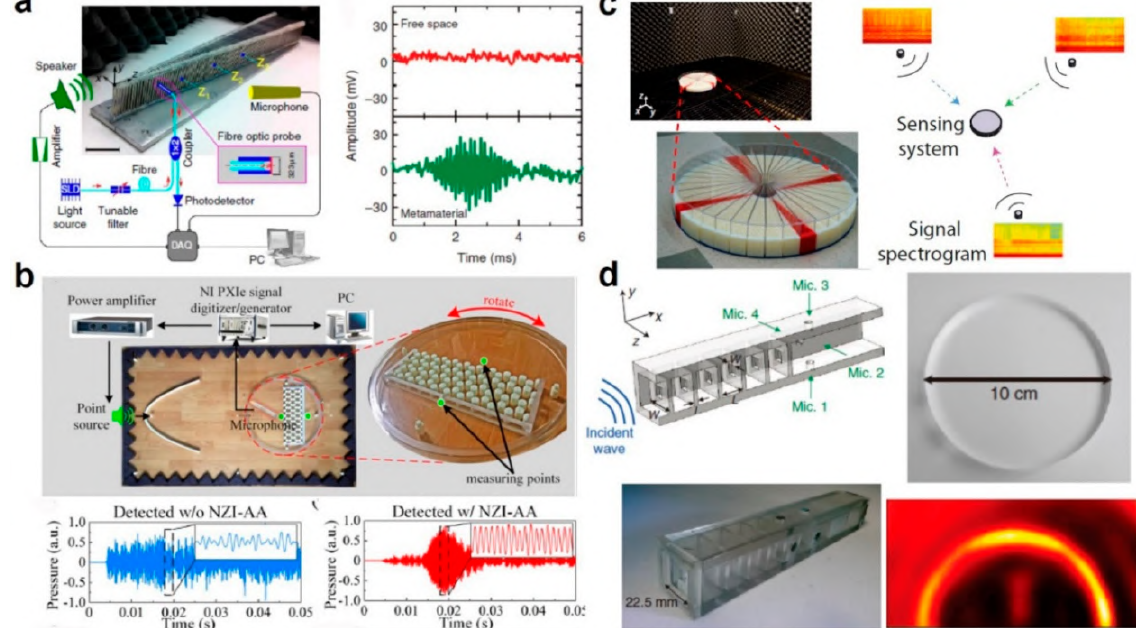
Figure 4. Acoustic metamaterials for sensing. ( a ) Schematic of the AMM hybrid sensing system, time-domain pulse signal in free space and in the metamaterial. Reproduced with permission from [96]. Copyright 2014, Nature. ( b ) Experimental setup for characterizing the NZI-AA sample on a rotating table, and time-domain pressure with and without the NZI-AA sample. Reproduced with permission from [11]. Copyright 2019, American Institute of Physics. ( c ) Fabricated metamaterial sensor and the schematic for the single-sensor listening device for sound detection from several sources. Reproduced with permission from [95]. Copyright 2015, PNA. ( d ) Schematic of the AMM with five symmetrical resonators, 3D printed prototype, optical image and the detected edge of a 10-cm-diameter disc. Reproduced with permission from [97]. Copyright 2015,